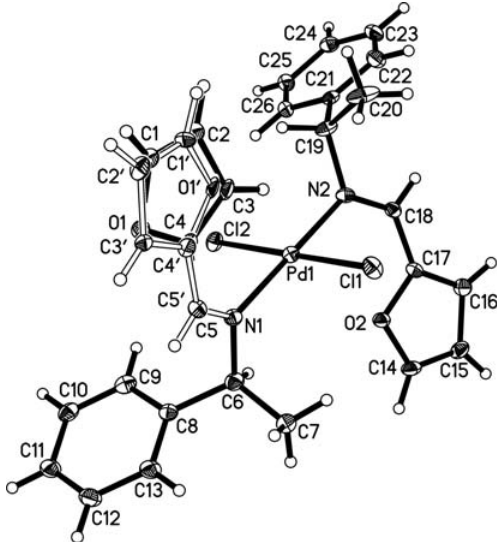
Table 2. Atomic coordinates and displacement parameters (in Å 2 )